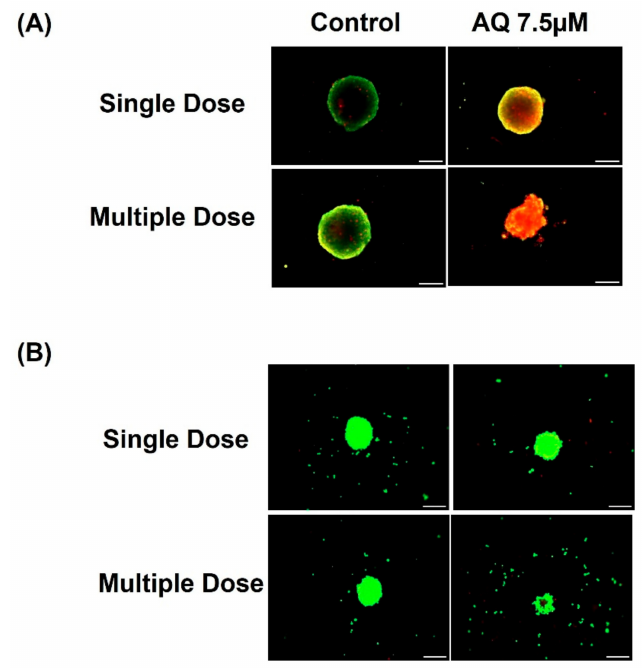
Figure 7. Representative live-dead stained spheroid images ( A ) MCF-7 and ( B ) MDAMB-231.